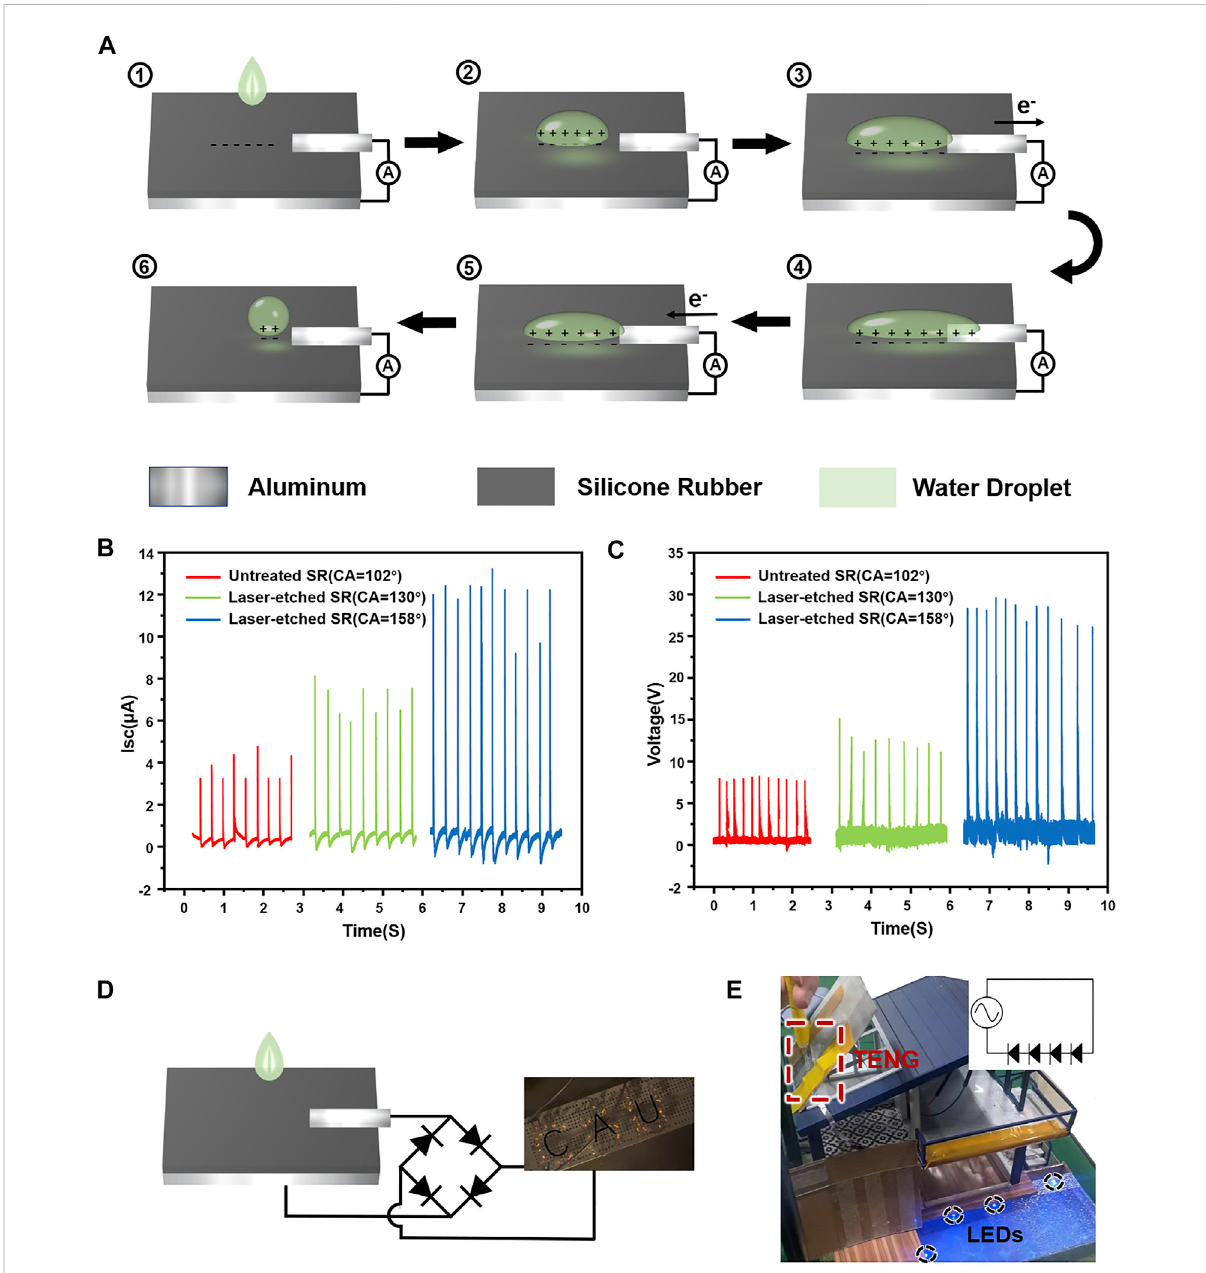
FIGURE 7 (A) Mechanism of the corresponding charge transfer. (B,C) Outputs of different droplets when they impinge on the friction layer with a 40 ° inclination of the TENG device. (D) Droplet lights up a “ CAU ” shaped LEDs through the TENG. (E) TENG lights up blue LEDs with rainwater power on the